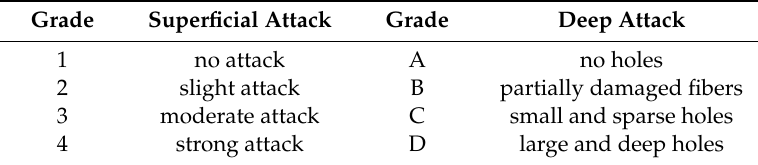
Table 1. Classes of damage attributed to wool samples exposed to clothes moth